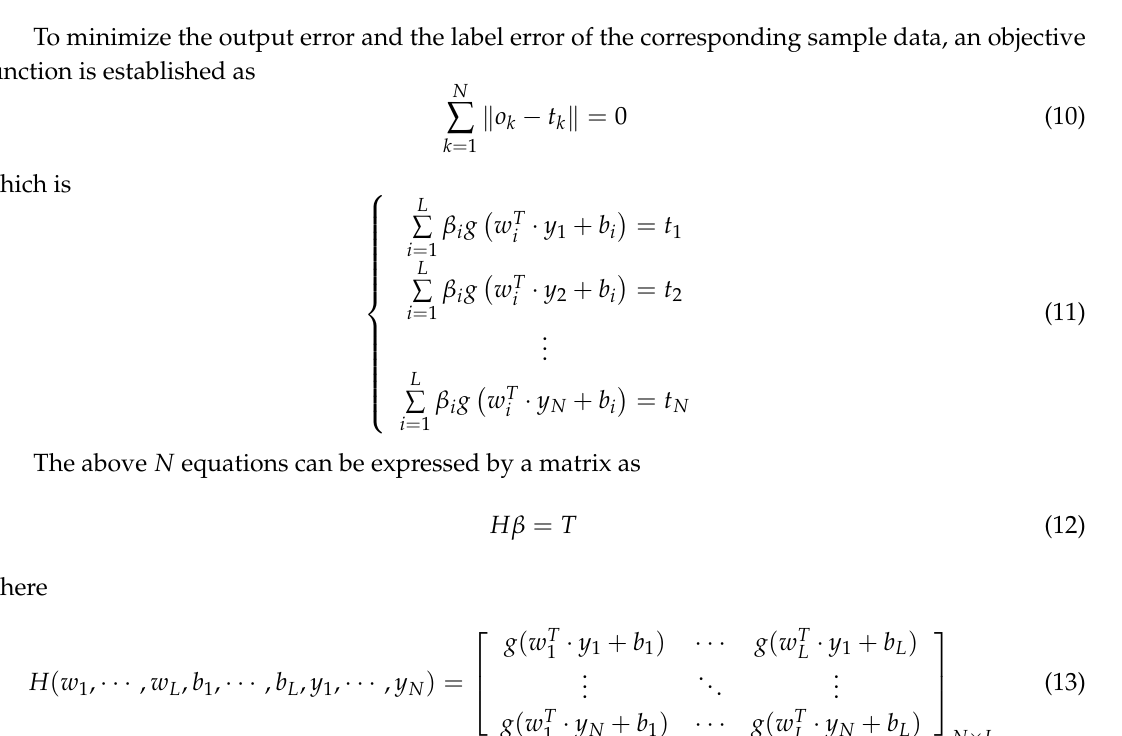
Figure 3. Single hidden layer neural